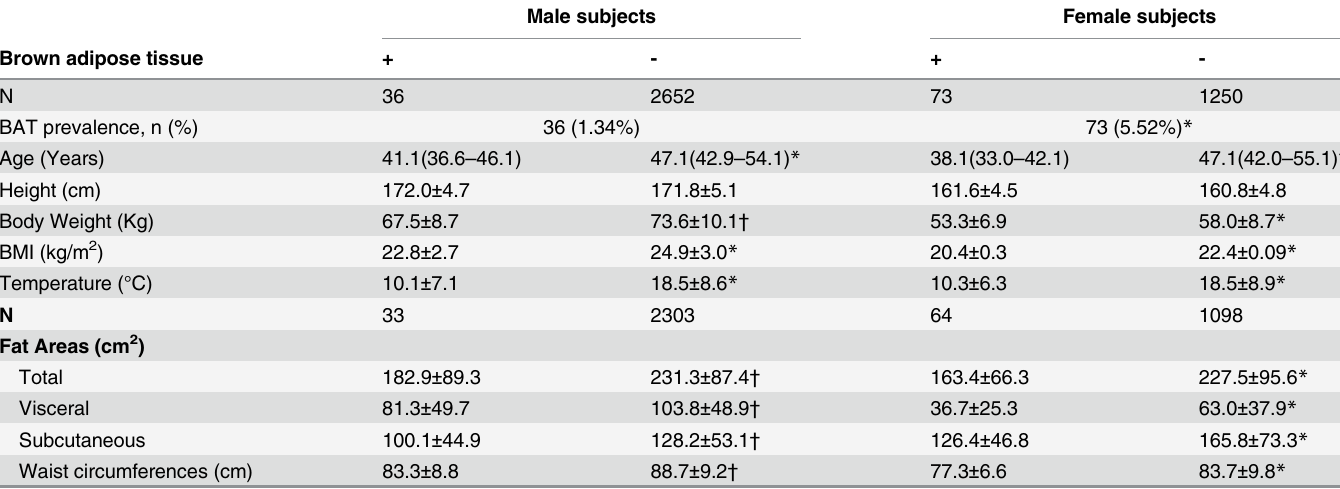
Table 2. Comparison of body fat areas between subjects bearing detectable (+) and undetectable (-) amounts of BAT by